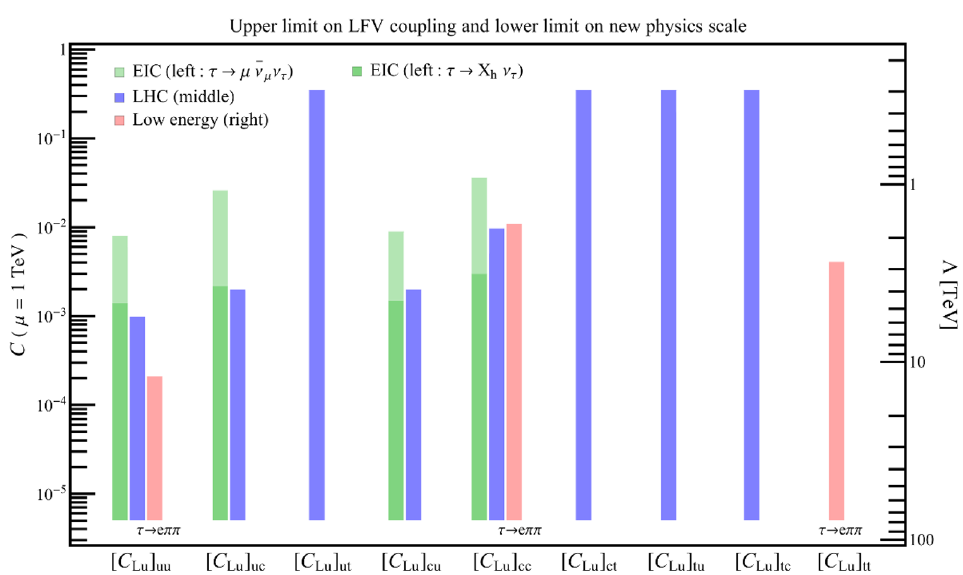
Figure 14 . Upper limit on C Lu (leftmost axis) and lower limit on new physics scale Λ (rightmost axis). For the EIC expected sensitivity, the light green bar corresponds to the result in table 7, while the dark green one represents the case in hadronic tau decay mode assuming (cid:15) n b = 0 in tables